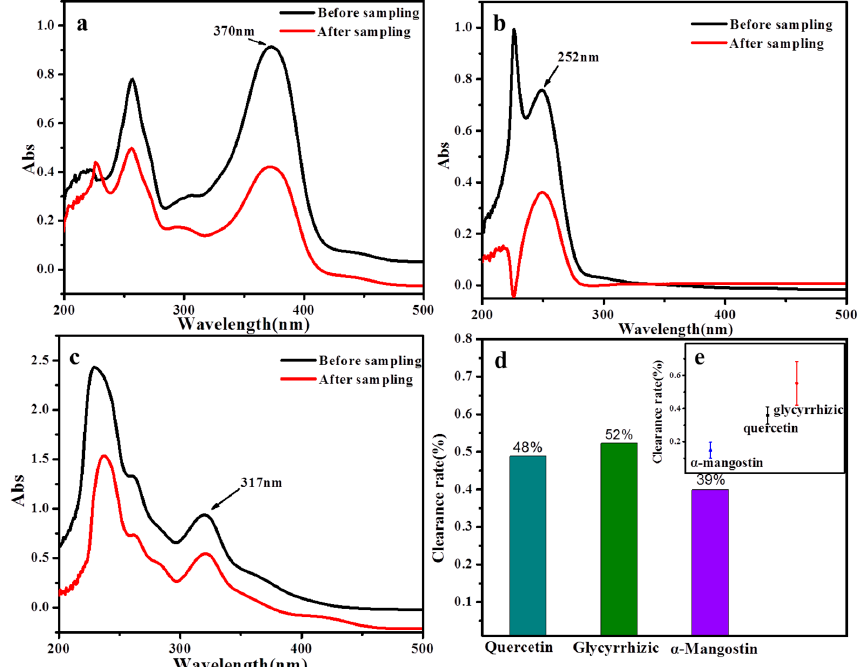
Figure 6. ( a ) UV curves for quercetin before and after sampling; ( b ) UV curves for glycyrrhizic before and after sampling; ( c ) UV curves for α -mangostin before and after sampling; ( d ) the clearance rate of three active molecules(%); ( e )Error bars for the clearance rate of three active molecules. As shown in Figure 7, the UV curves for nanofiber membrane with three active molecules after and before sampling display consistent variation characteristics. The UV absorbance of three kinds of active substances after sampling started to decrease; there was no peak type change and new peaks would appear. In the process of the active substance and free radicals reaction, free radicals would react with phenolic hydroxyl groups on the benzene ring, strip the hydrogen ions on the phenol hydroxyl and generate H 2 O, ROOH etc. After being striped the hydrogen, phenolic hydroxyl was affected by the resonance of aromatic ring conjugate system and generated stable half quinone free radicals. This reaction terminated free radical chain reaction, at the same time n- π * transition electronic decreased significantly. The loss of active molecules leaded to the decrease of absorbance,